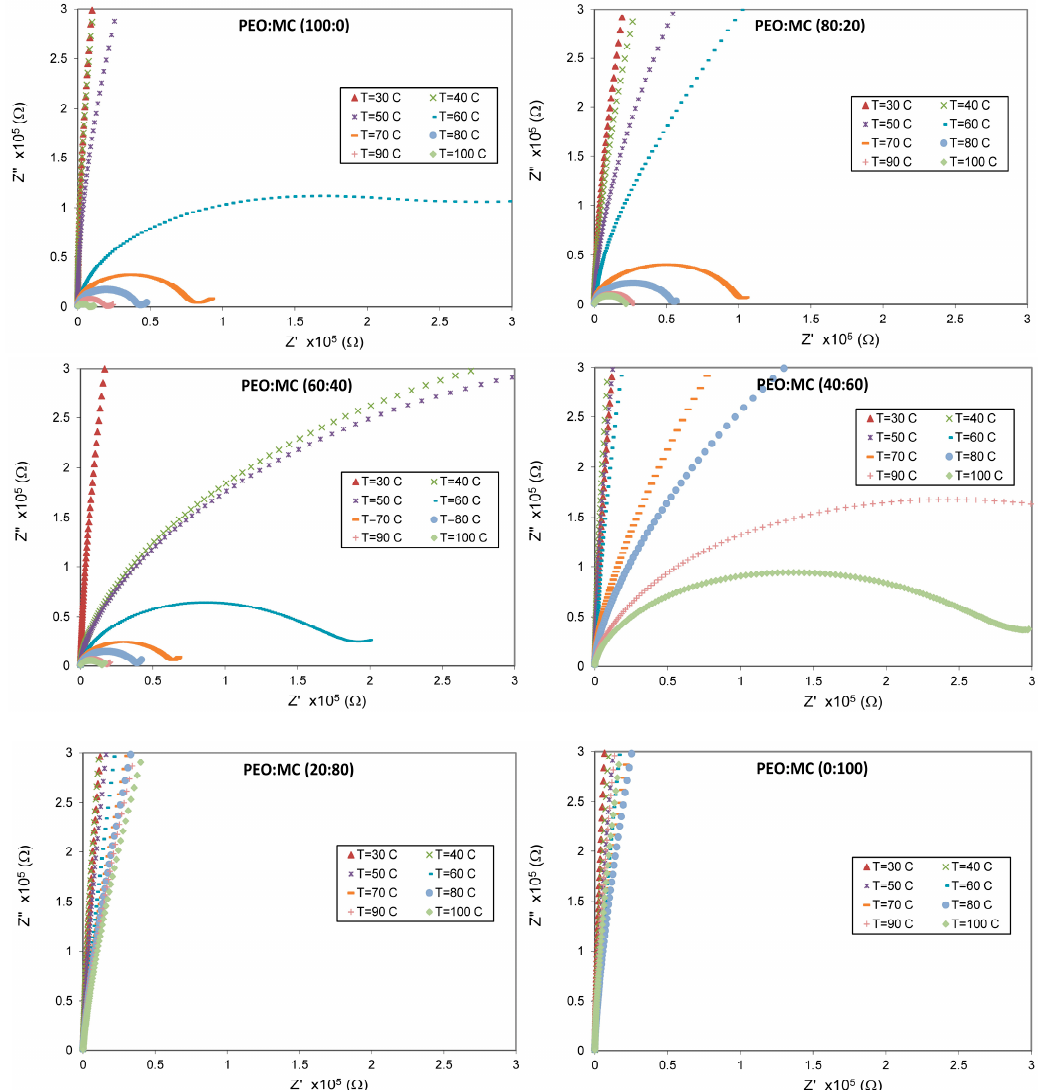
Figure 7. Nyquist impedance plots for PEO:MC films with different composition in the temperature range of 303–373 K.